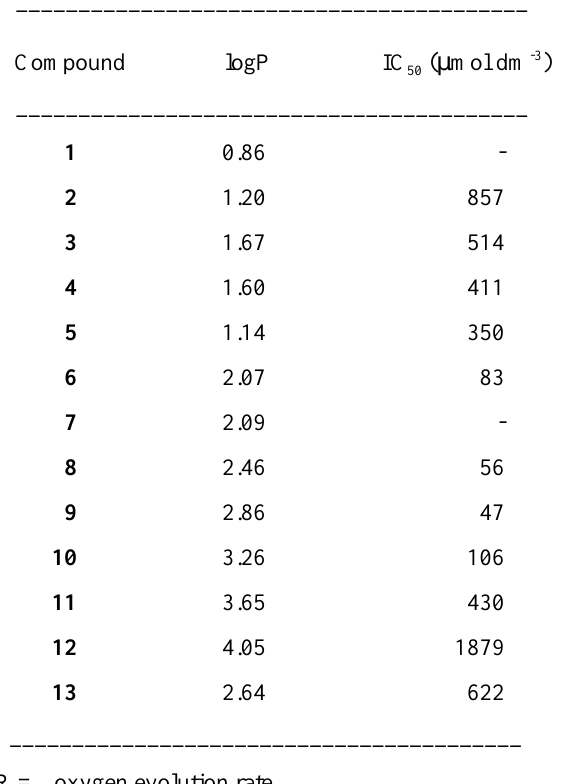
Table 2. Experimental values of IC of the studied compounds concerning 50 OER inhibition in spinach chloroplasts and calculated